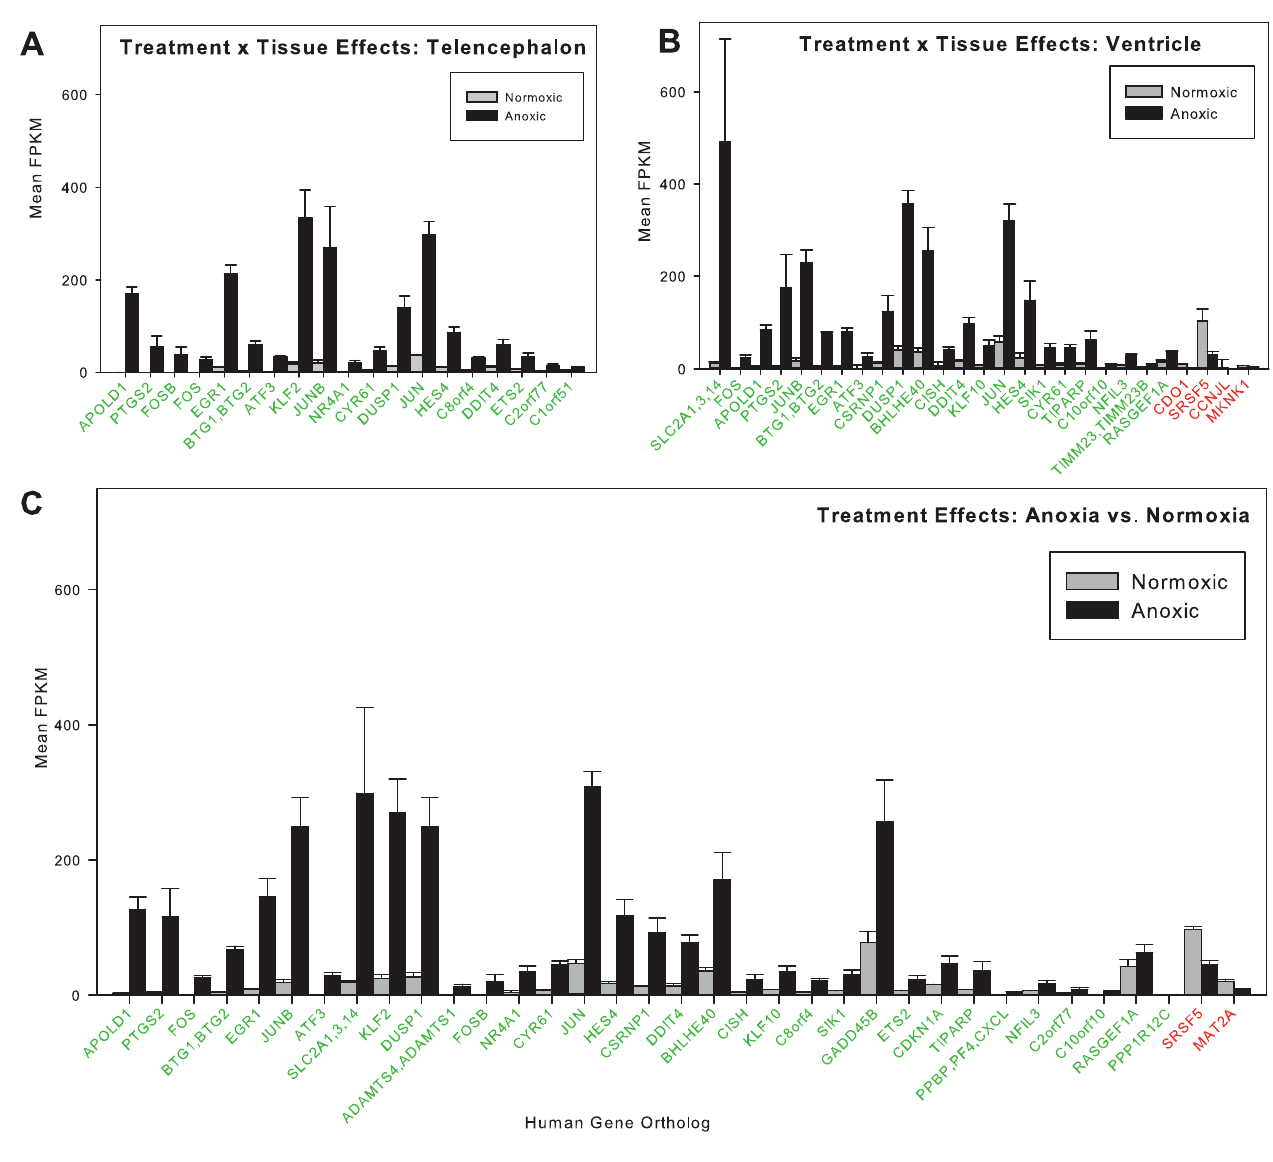
Fig 4. Mean ± SEM FPKM values measured for differentially expressed genes. (A) Values in normoxic and anoxic telencephalon, (B) normoxic and anoxic ventricle and (C) all normoxic and anoxic tissue combined. Genes with green font indicate increases in expression resulting from anoxia. Genes with red font indicate decreases in expression resulting from anoxia. In each plate, genes are arranged in order of decreasing fold expression. Only genes that changed by (cid:1) 2.0 fold or (cid:3) 0.5-fold were included. Several genes were abbreviated for simplicity: “ PPBP,PF4,CXCL ” includes Ppbp/Pf4/Cxcl1/Pf4v1/ Cxcl6/ Cxcl3/ Cxcl5/ Cxcl2/ Il8/ Cxcl10/ Cxc11; “ CLK,PPIL3 ” includes Clk3/Ppil3/Clk1/Clk4). The mean FPKM values, P-values, sequence length, and exon density for each of these genes can be found in S1 – S3